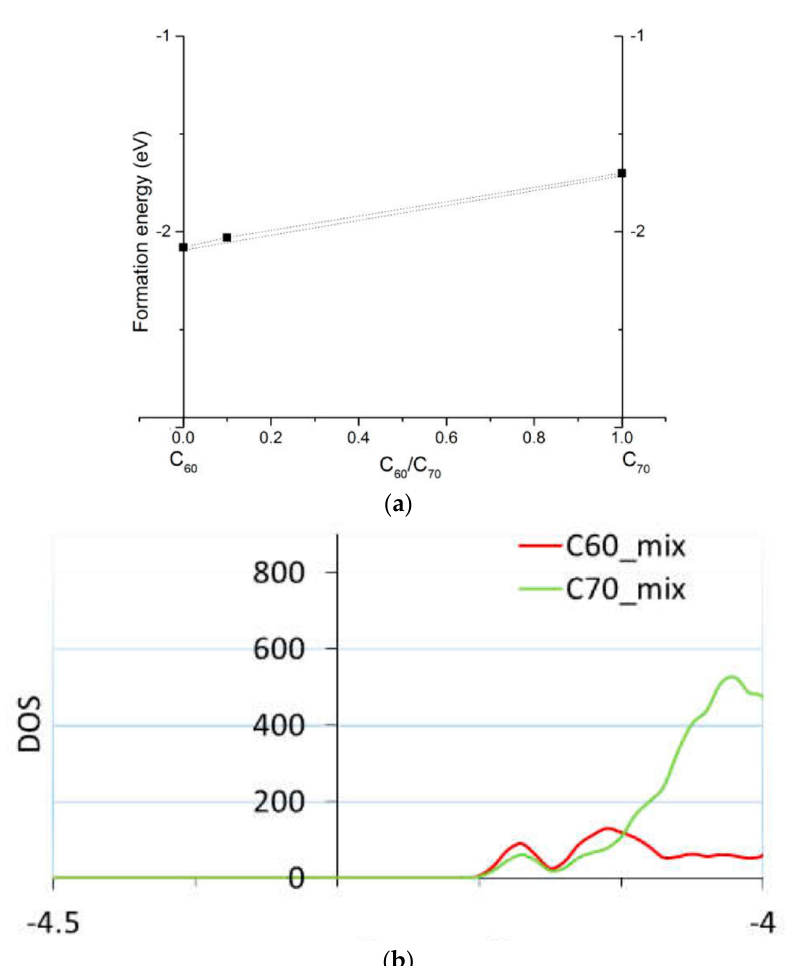
Figure 2. The computed formation energies ( a ) of C60, C70, and the mixture of C70 and C60; and a zoom in into the density of states (DOS) of the mixture ( b ) showing separate C60 and C70 contributions. Adopted with permission from the Supporting Information of [42]. Copyright (2018) American Chemical Society.